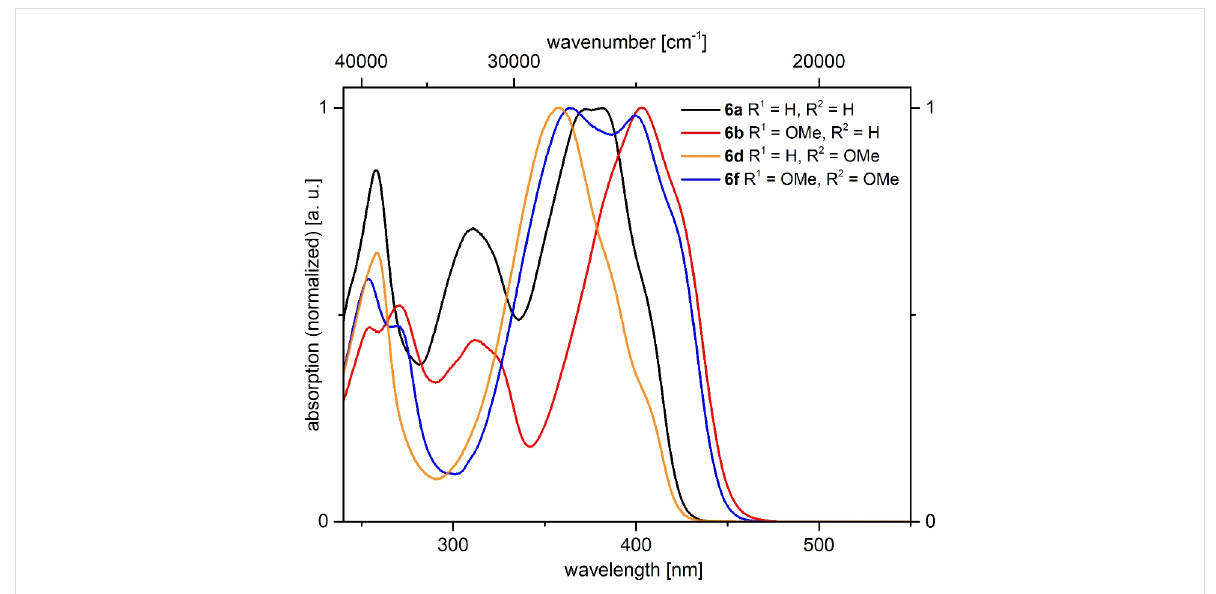
Figure 9: Selected normalized absorption spectra of α -pyrones 6a , 6b , 6d , and 6e recorded in dichloromethane at T = 298 K.